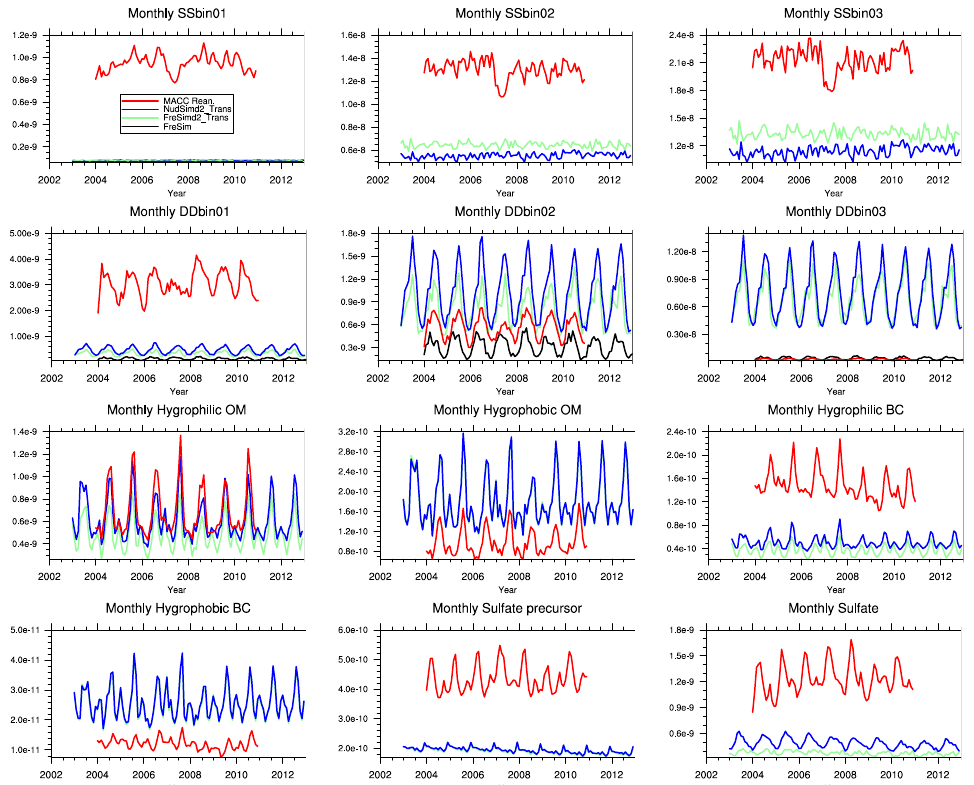
Figure 1. Time series of monthly mean global bin concentrations (kgkg − 1 ) in the lower troposphere (1000–500hPa layer) for the FreS- imd2_Trans (green line), NudSimd2_Trans (blue line), and MACC Reanalysis (red line). In addition, dust bin concentrations are added for the FreSim simulation (black line, 2004 repeated 10 times). The 12 “bins” of the aerosol scheme are shown.